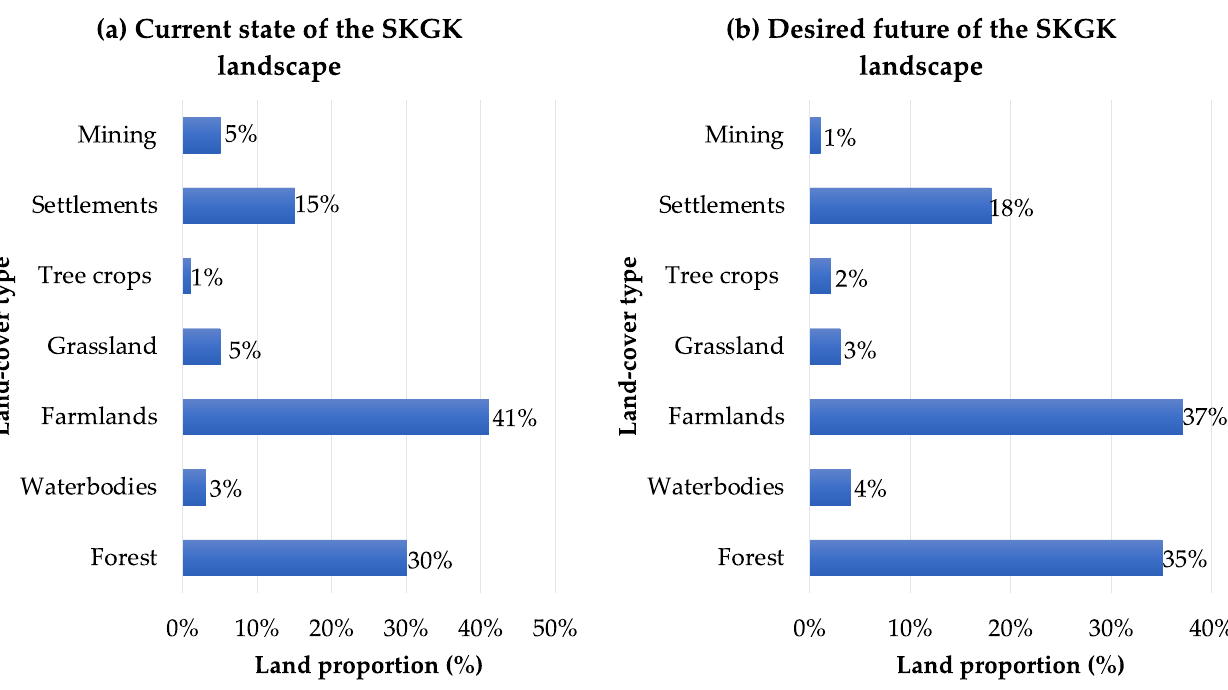
Figure 6. Perceived current state ( a ) and desired future composition ( b ) of the Sanyiga Kasena Gavara Kara (SKGK) landscape as visualised by institutional actors.